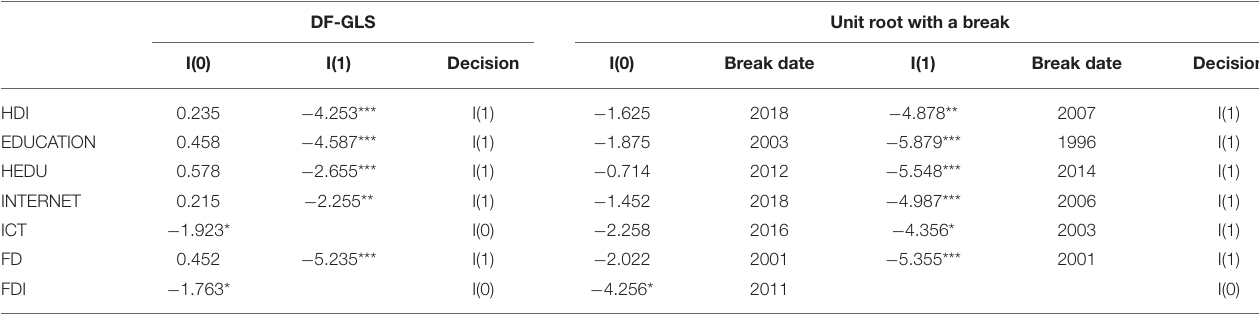
TABLE 2 | DF-GLS and unit root with a